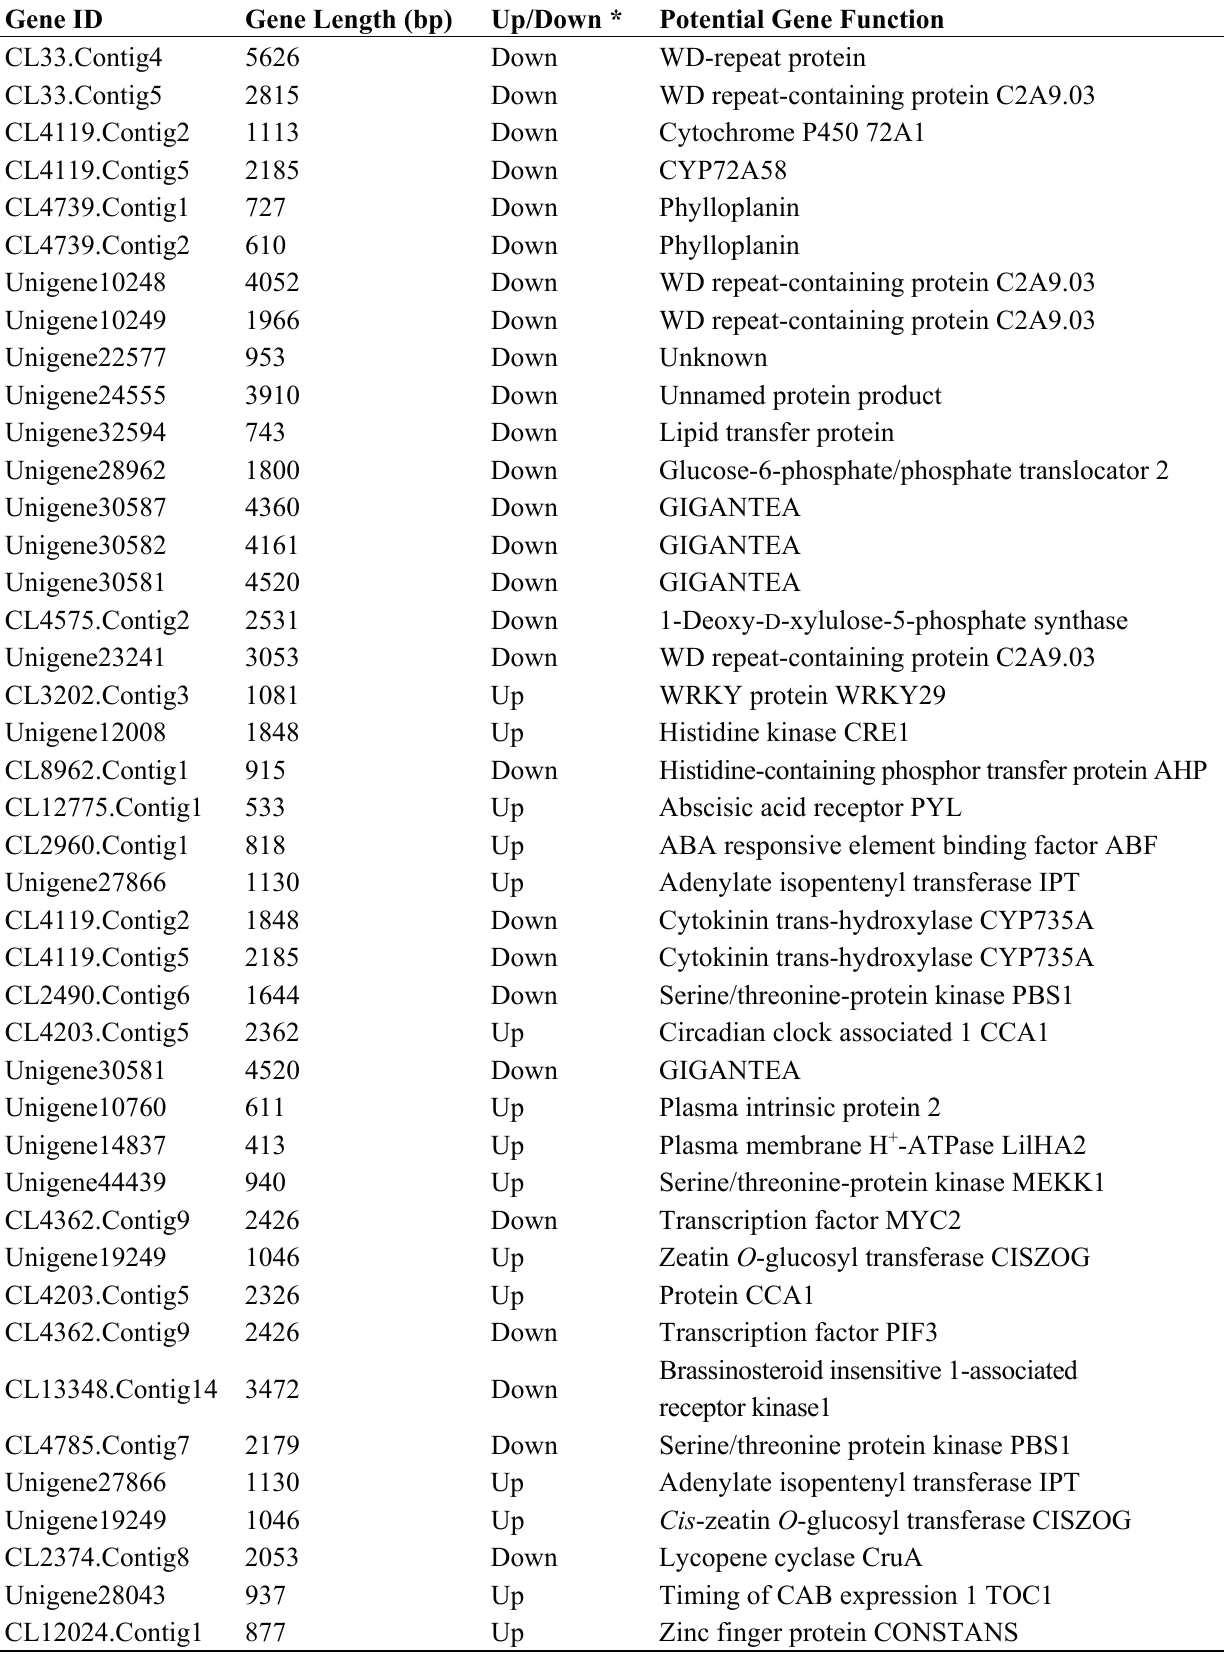
Zinc finger protein CONSTANS * Up or down regulation indicated the expression in the PFI vs. PF comparison. In the PFI-60 vs. PFI comparison, the tendencies were